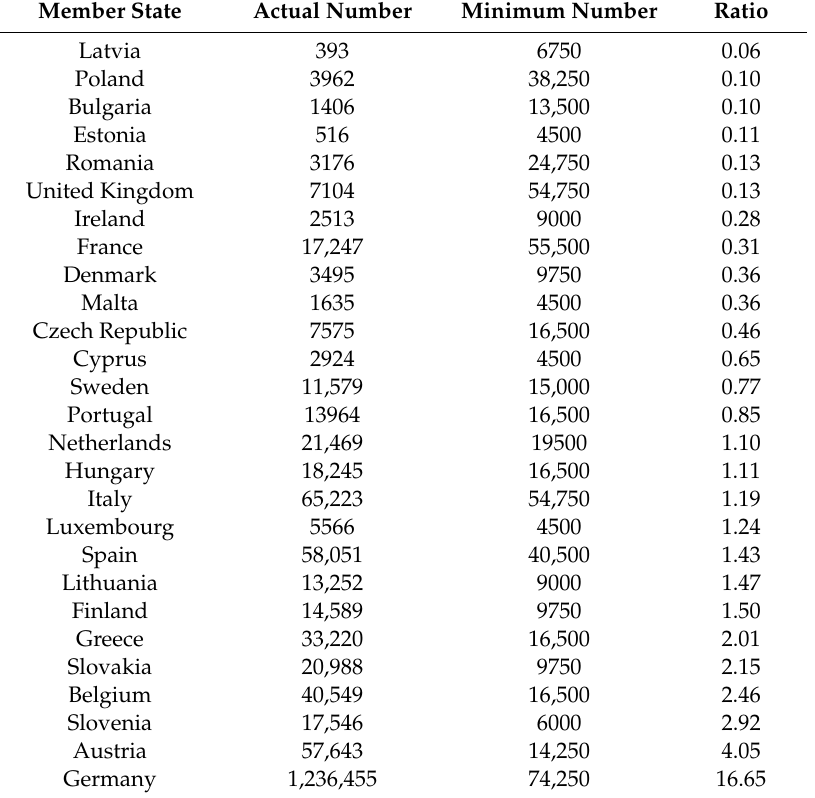
Table 1. Support for Right2Water broken down by member